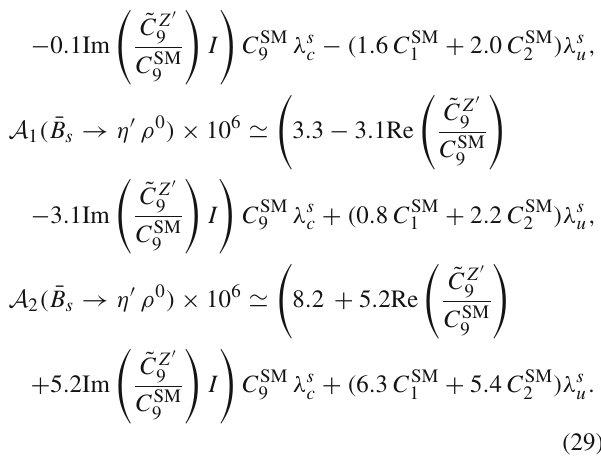
normalized by the SM Wilson coefficient C SM 9 ( S ψφ ) for M Z (cid:3) = 1TeV s